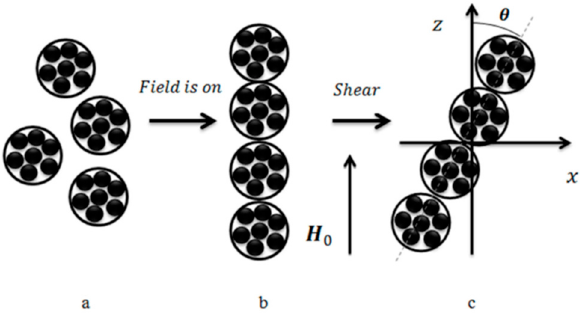
Figure 5. Spherical agglomerates of magnetic particles initially isotropically distributed in polymer matrix ( a ) form chain-like aggregates ( b ) in external magnetic field. Tilting of aggregate chains takes place under simultaneously applied magnetic field and shear deformations ( c ) [61].